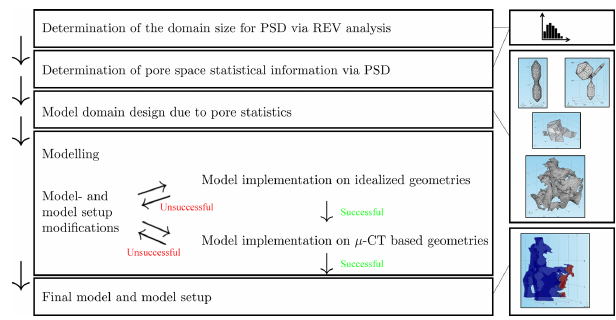
Figure 6. Schematic overview of the workflow for deriving the fi- nal 2-phase flow model and model set-up for complex µ -CT-based model